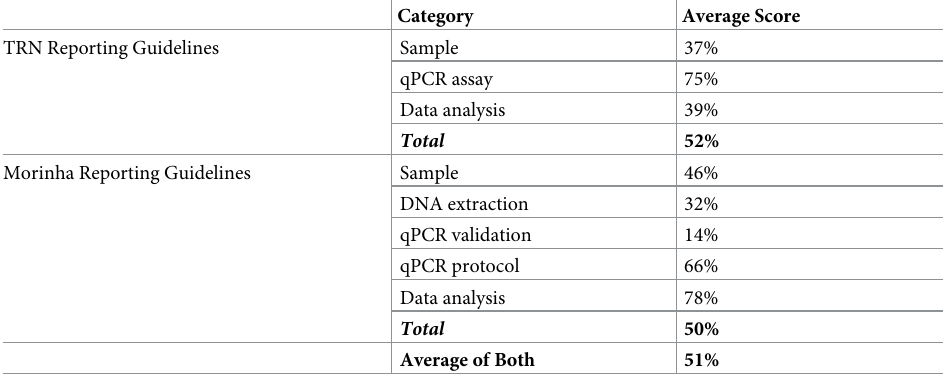
Table 2. Results of reporting guidelines analysis for TRN and Morinha reporting